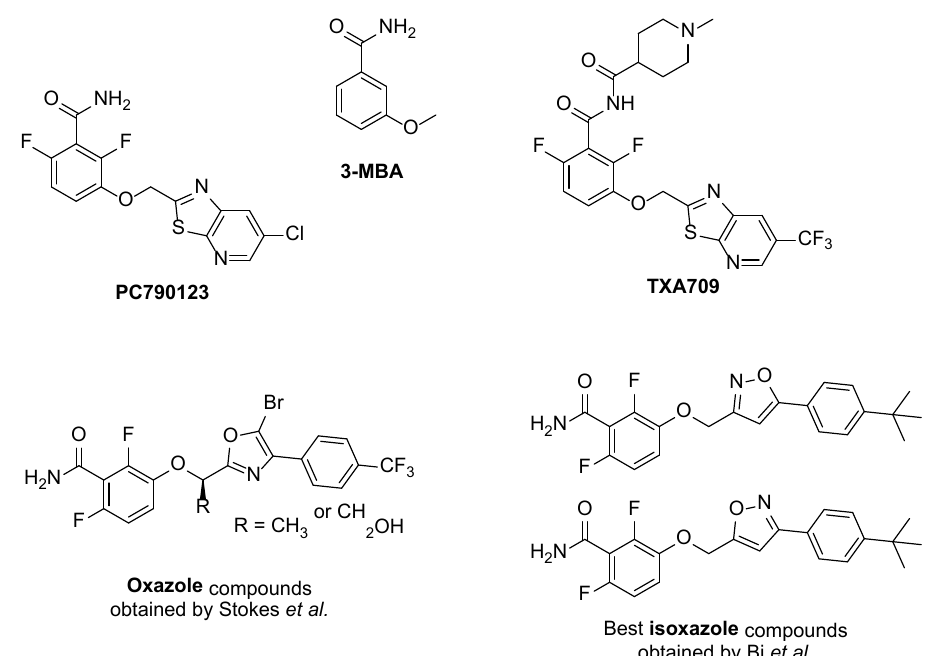
Figure 1. Structure of several reported FtsZ inhibitors as antibacterial agents.